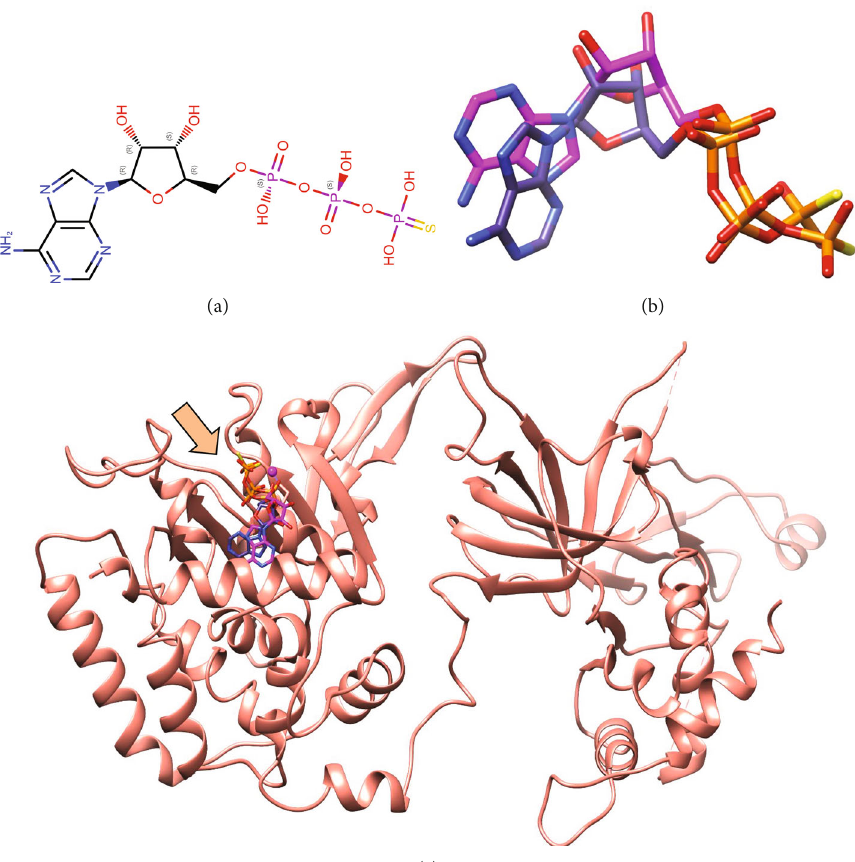
Figure 2: Re-docking study of MCM7 with: (a) AGS; (b) superimpose structures of AGS (magenta) and redocked (slate); (c) redocked AGS highlighted (coral arrow) in complex with